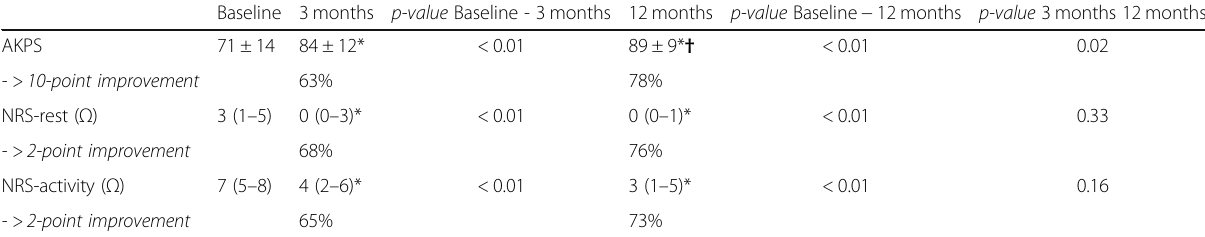
Table 2 Outcome scores